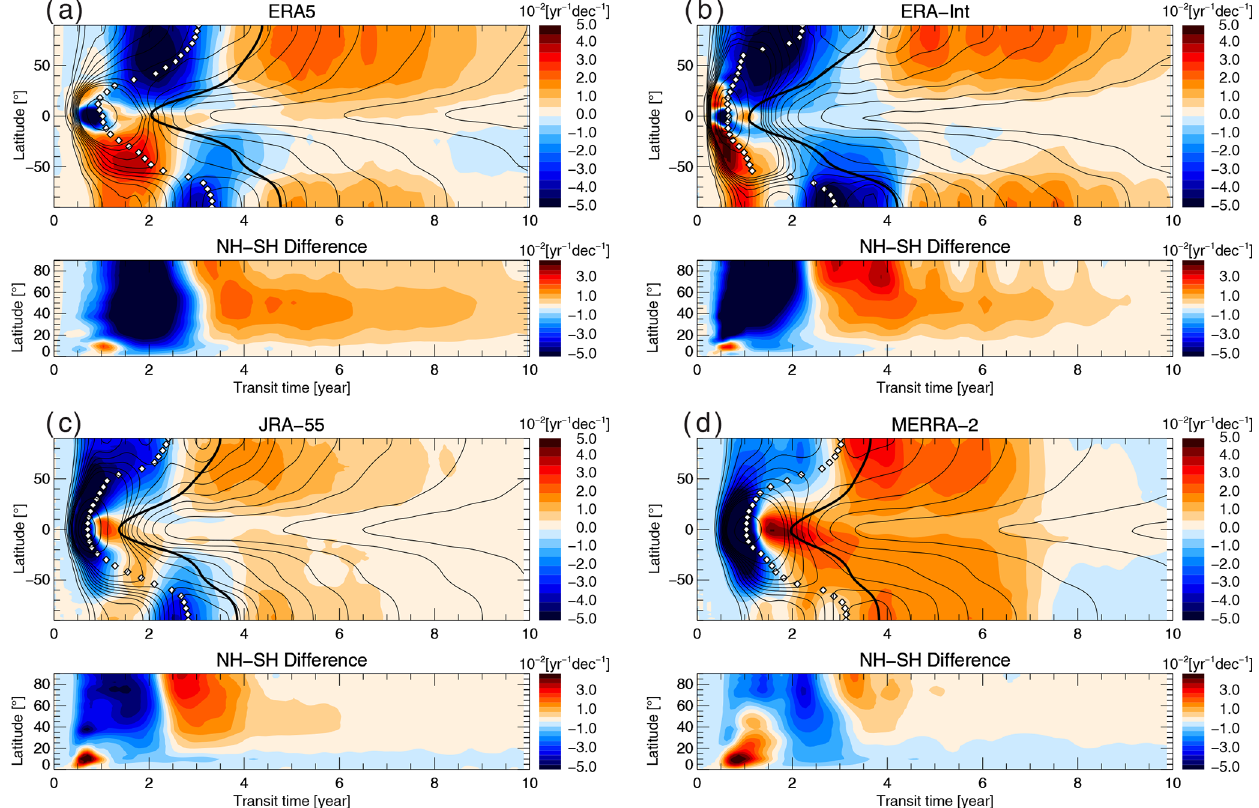
Figure 8. Age spectrum trends on the 500K potential temperature surface over the period 2005–2017 for ERA5, ERA-Interim, JRA-55 and MERRA2. Thin black lines show contours of the climatological age spectra, and the colour shading shows the trend. Each horizontal cut represents the climatological age spectrum (black lines) and its trend (colour shading) at that particular latitude. The bottom panels show the hemispheric difference in the trends (NH minus SH). Thick black lines show mean age, white symbols modal age (transit time of strongest spectrum peak).